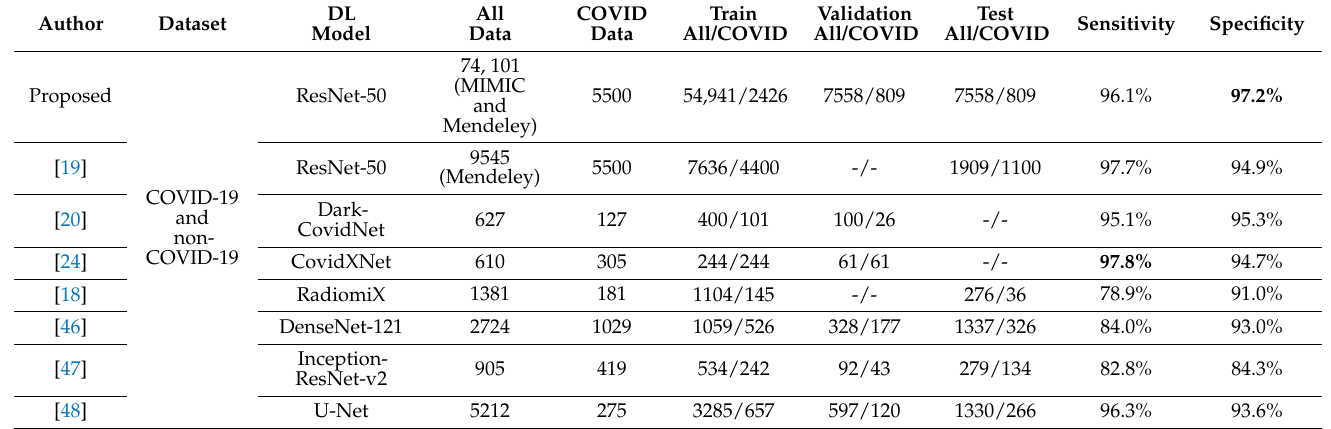
Table 9. Performance comparison of the proposed methodology with other studies.